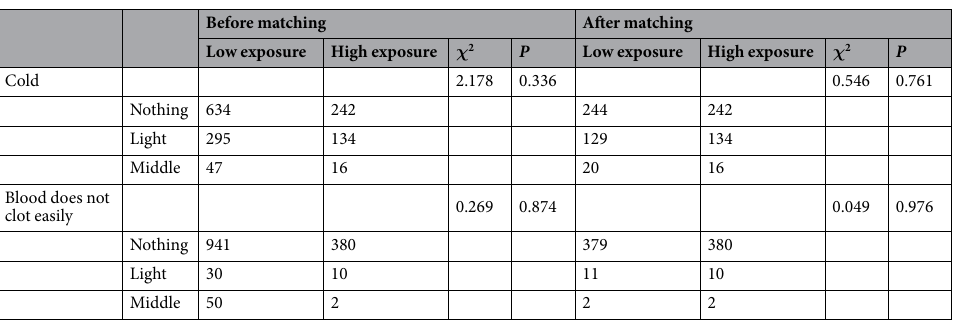
Table 10. Difference Test of Symptom Frequency in Immune and endocrine system before and after